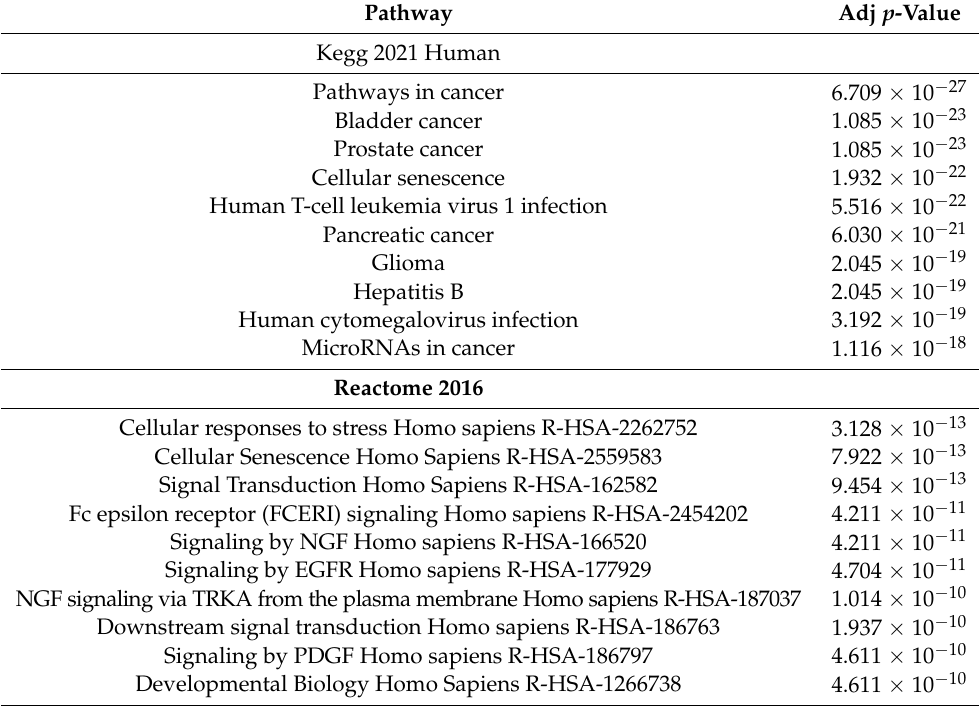
Table 2. The ten most significantly enriched Kegg 2021 human and Reactome 2016 pathways sorted by adjusted p-value, based on a deregulated miRNA gene target